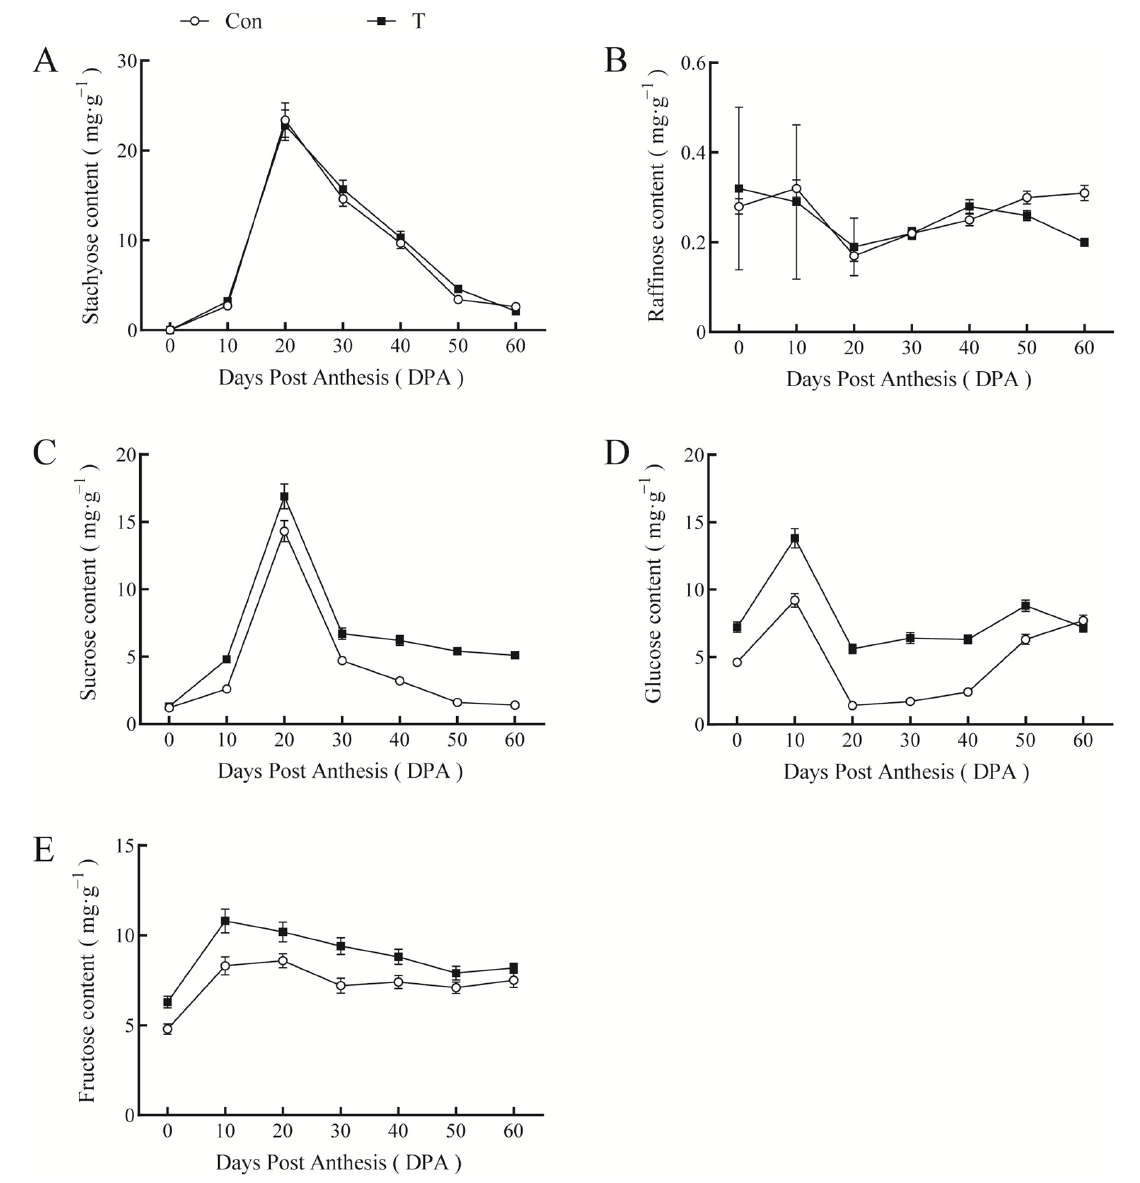
Figure 8. Effect of NAA and EBR on soluble sugar content in giant pumpkin fruit. ( A ) Stachyose, ( B ) raffinose, ( C ) sucrose, ( D ) glucose, ( E ) fructose.